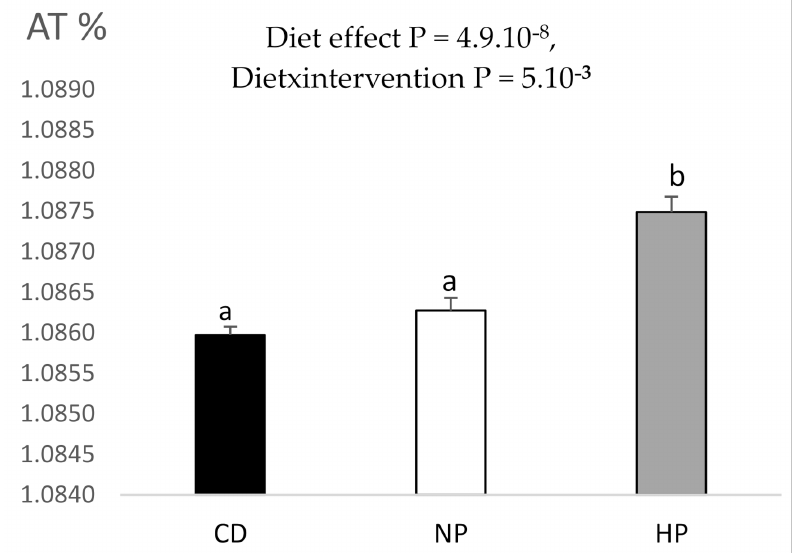
Figure 7. 13 C enrichment observed in 24 h urines of participants. Data are mean ± SEM. The p value is indicated on the graph, when the difference is significant, for the diet and period effect (ANOVA). When the effect is significant, different letters indicated significant differences between groups. CD, control diet; NP, normal protein, high-fat, hypercaloric diet diet; HP, high-protein, high-fat, hypercaloric